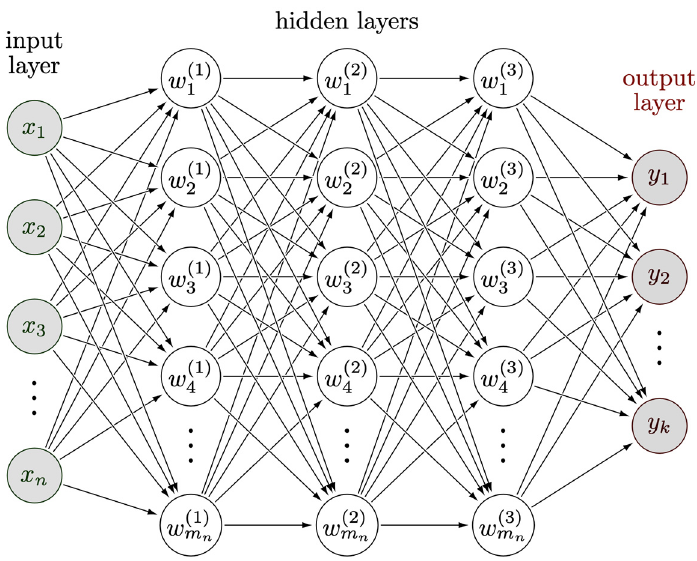
Figure 3. Schematic illustration of a neural network. x 1 . . . x n represent the network inputs, ω 1 . . . ω m represent the network weights and finally, y 1 . . . y k represent the network outputs used in the NN model.